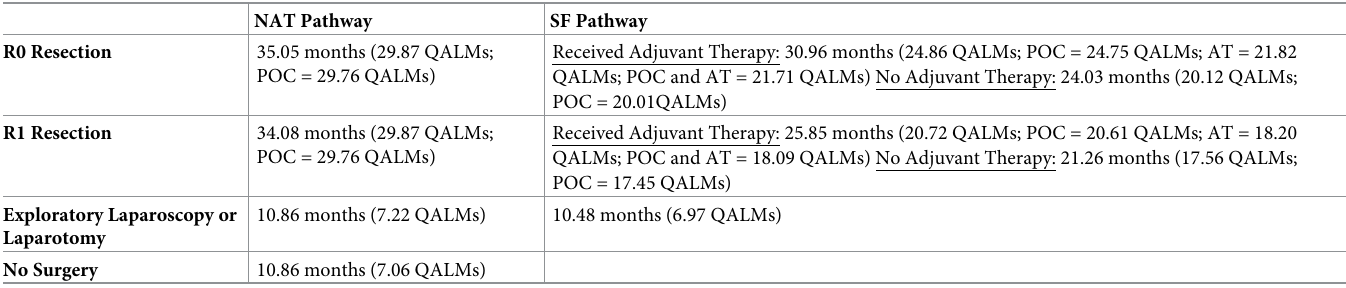
Table 3. Results from Markov cohort